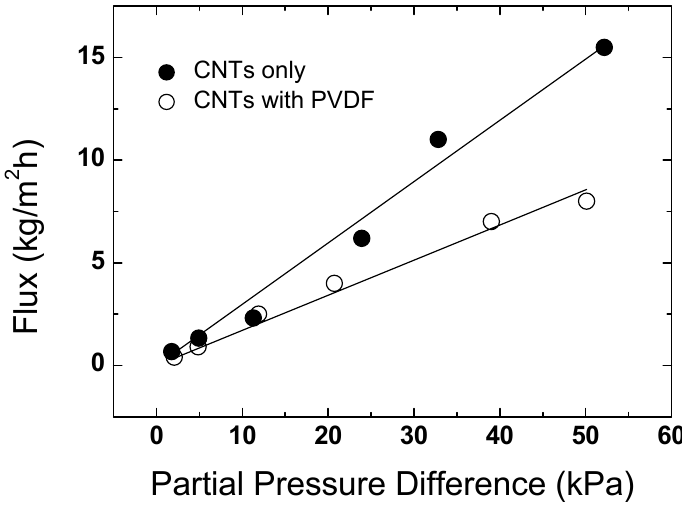
Figure 10. Dependence of water vapor flux on the partial pressure difference across a Bucky-paper membrane in a direct contact membrane distillation setup [stream